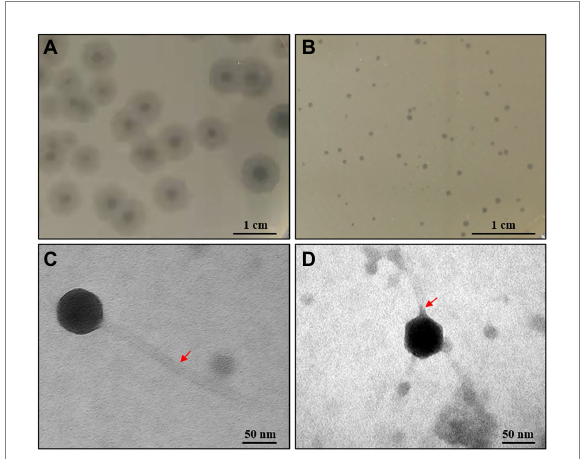
FIGURE 1 Plaques and ultrastructure observations of phages. (A,B) Plaques formed of phage CM_Kpn_HB132952 and CM_Kpn_HB143742 on the lawn of KPHB132952 and KPHB143742, respectively. (C,D)